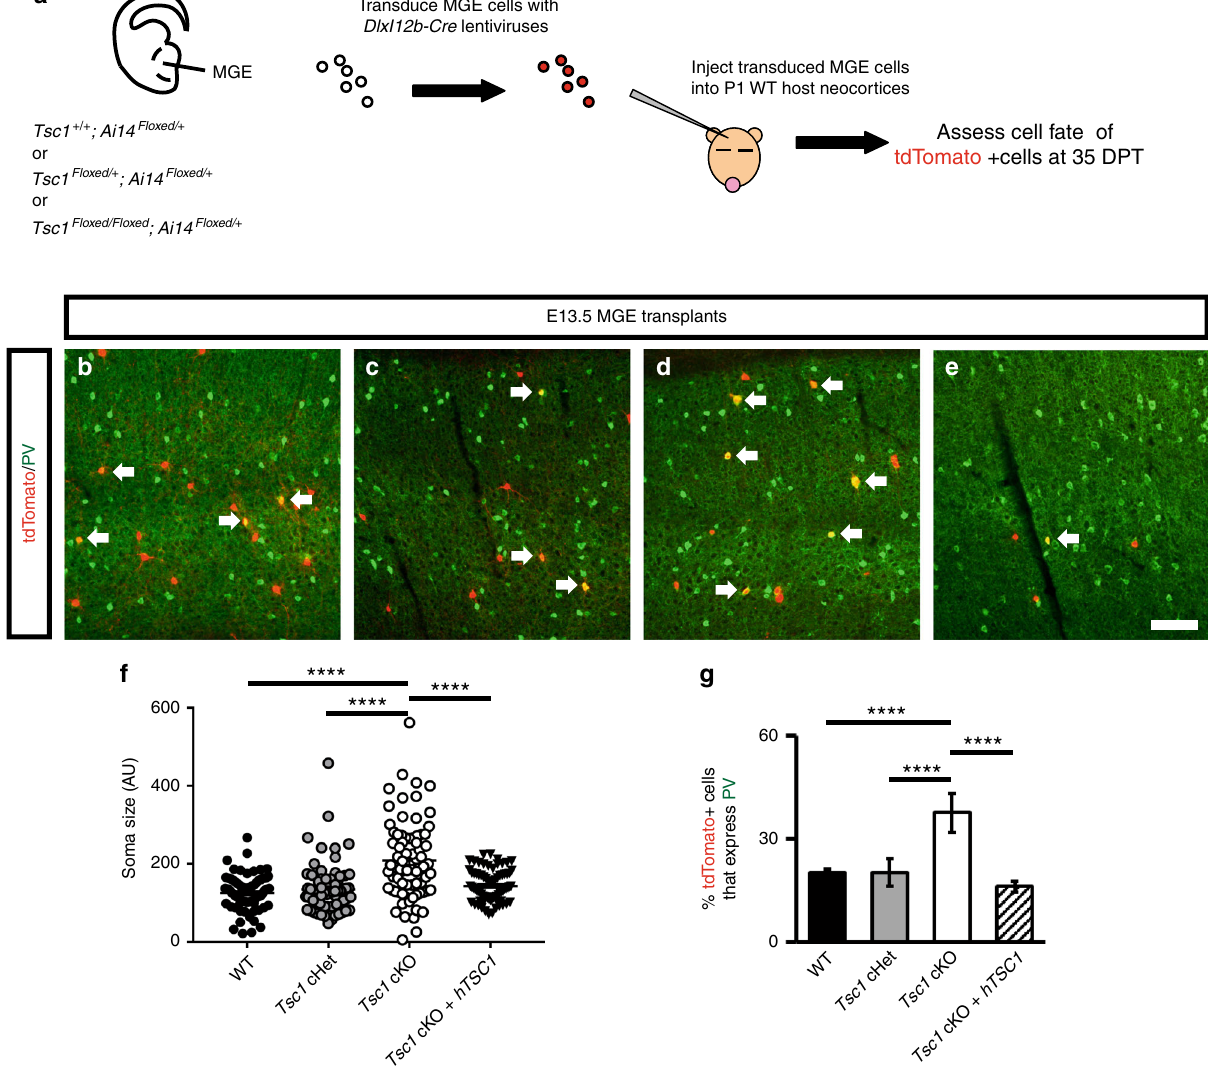
Fig. 7 Cell autonomous increase in PV expression in Tsc1 null MGE-derived CINs. a Schema depicting the transplantation procedure. E13.5 Ai14 Floxed/ + MGE cells (tdTomato + ) that were either Tsc1 + / + , Tsc1 Floxed/ + or Tsc1 Floxed/Floxed were transduced with a DlxI12b-Cre lentivirus, transplanted into WT P1 neocortices, then developed for 35 days post-transplant (DPT). Coronal immuno fl uorescent images of neocortices transplanted with Tsc1 + / + (WT), Tsc1 Floxed/ + (cHet) or Tsc1 Floxed/Floxed (cKO) MGE cells show co-expression of tdTomato and PV ( b – d ). In addition, human TSC1 was expressed in Tsc1 Floxed/ Floxed (cKO) MGE cells and assessed in the same manner ( e ). Arrows point to co-expressing cells. Quanti fi cation of soma size of the tdTomato + cells ( f ) : One-way ANOVA, (F 3, 296 = 24.1, P < 0.0001; cKO vs. all groups, p < 0.0001), n = 3 mice (25 cells counted from each). (AU) arbitrary units. Quanti fi cation of the proportion of tdTomato + cells that express PV ( g ): Chi-squared test with Yate ’ s correction, (cKO vs. all groups, p < 0.0001), n = 3, all groups (330 WT, 821 cHet, 913 cKO and 317 cKO/h TSC1 cells counted). Data are represented as mean ± SD in ( f ) and ± SEM in ( g ). Scale bar in ( e ) = 100 µ m. **** p < 0.0001. Source data are provided as a Source Data fi